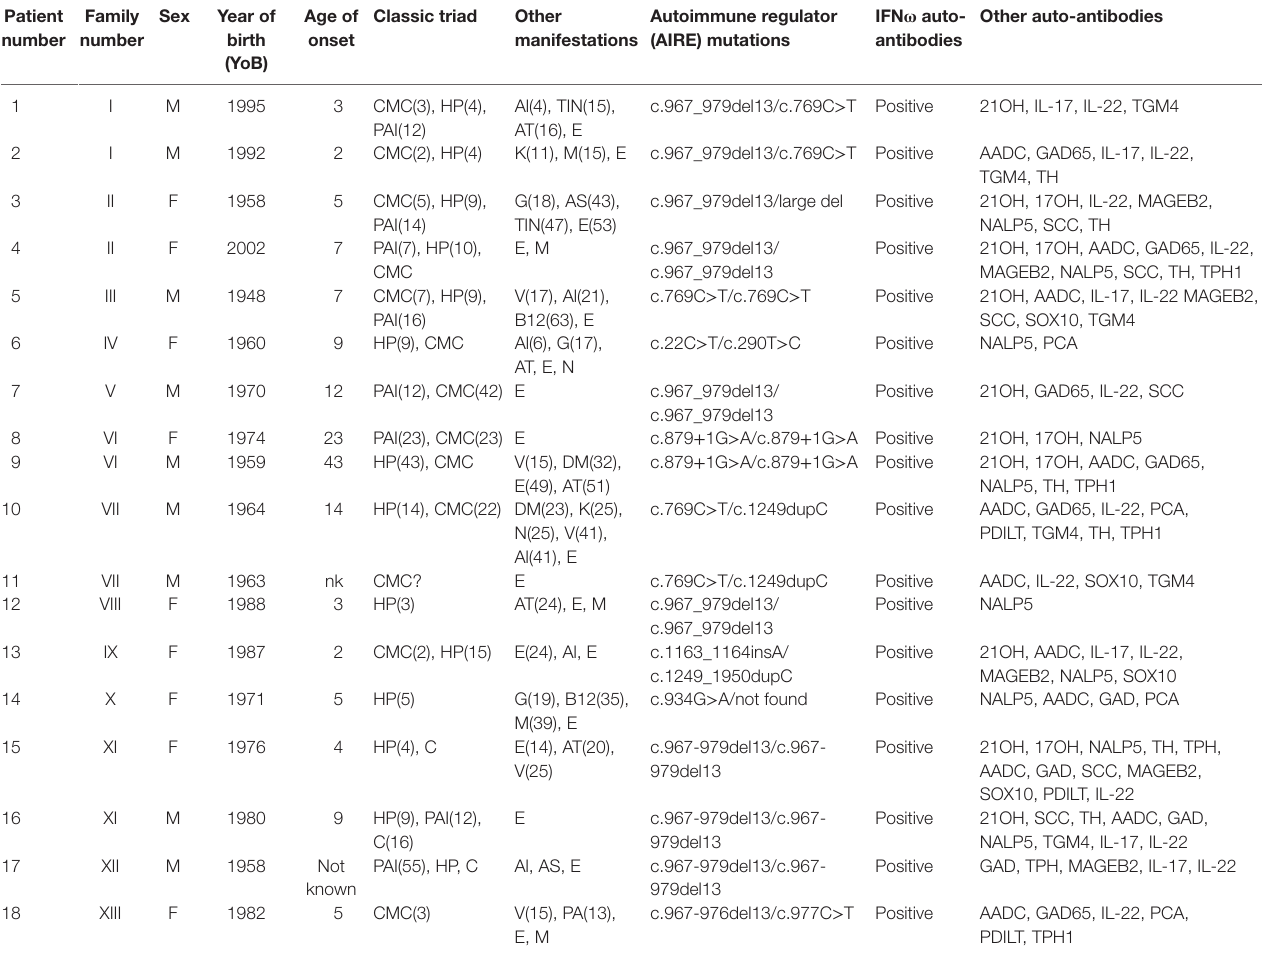
Table 1 | Characterization of the autoimmune polyendocrine syndrome type 1 (APS-1) patients. Patient Family number number